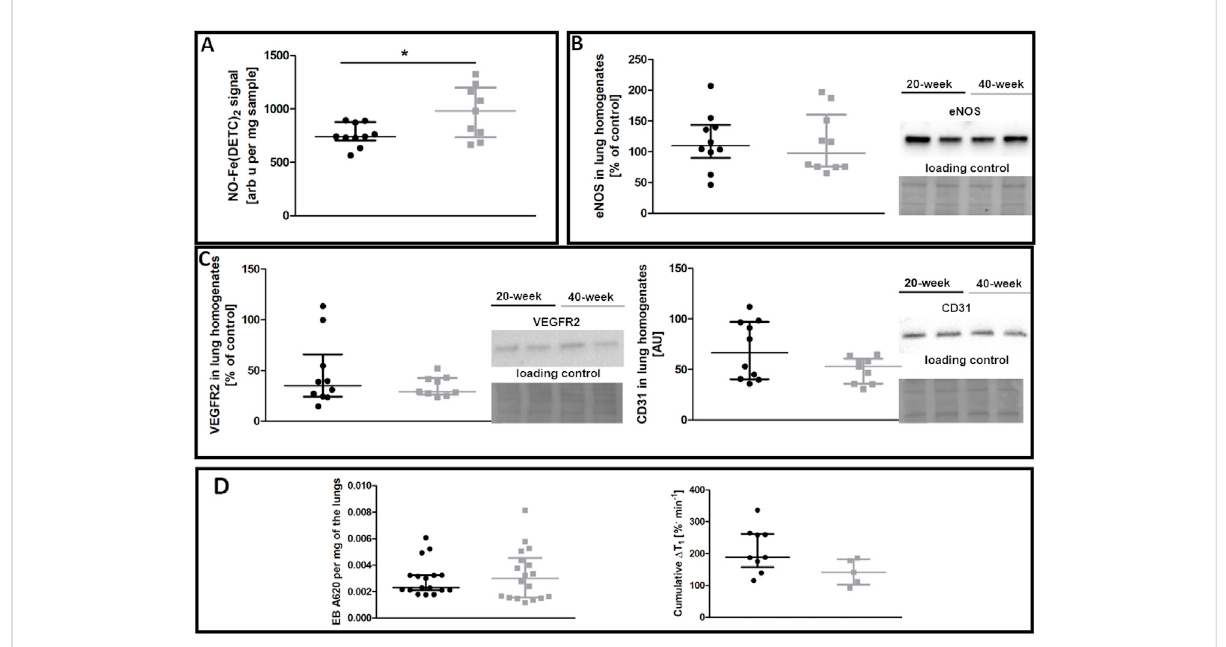
FIGURE 2 Lung functional parameters of control untreated 20-week-old and 40-week-old BALB/c mice. Black symbols denote 20-week-old untreated control mice, and grey symbols denote untreated control 40-week-old mice. (A) iNOS-independent NO production in the lungs ( n = 9 – 10). (B) eNOSlevelsinlunghomogenates( n =10). (C) Levelsofotherendothelium-speci fi cproteinsVEGFR2andplateletendothelialcelladhesionmolecule (CD31) in the lung homogenates are shown by representative Western blots ( n = 9 – 10). (D) Pulmonary permeability based on the spontaneous EBdepositioninthelungs( n =24 – 26),andtheamountsofextravascularliquid(MRI)inthelungparenchymainresponsetoacuteL-NAMEtreatment ( n =5 – 9).AlldatawerecomparedusingaparametricunpairedStudent t -test,withWelch ’ scorrectionforNO-Fe(DETC) 2 (re fl ectingNOproduction), except for VEGFR2 levels and EB lung deposition which were compared with a non-parametric Mann-Whitney U test. The results are shown as the median and IQR. Key: * p <